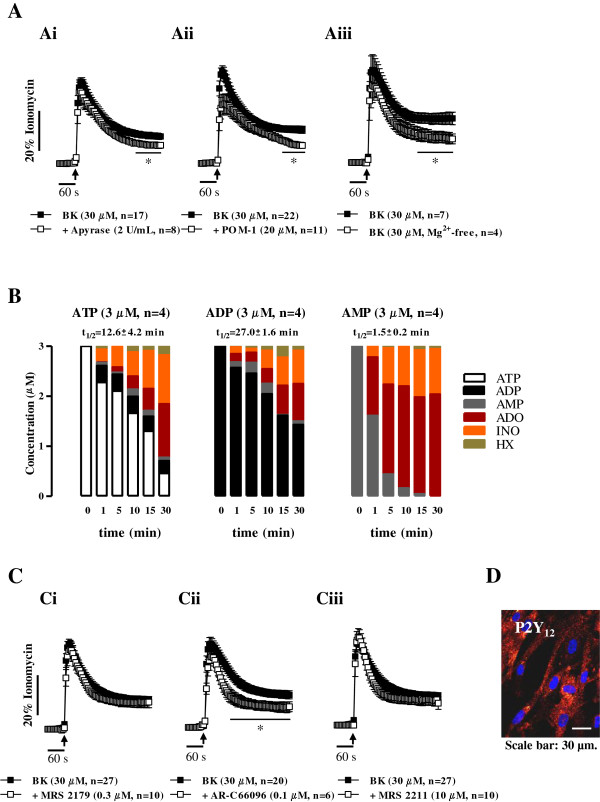
Bradykinin-induced [Ca2+]i mobilization is partially dependent on the activation of P2Y12 purinoceptors. Panel A shows the effect of bradykinin (BK, 30 μM) after pretreating human subcutaneous fibroblasts with apyrase (2 U/mL, Ai), which catabolizes ATP/ADP into AMP, and after inhibition of ectonucleotidases, with POM-1 (20 μM, Aii) or after removing Mg2+ from the incubation fluid (Aiii). Panel C shows the effects of BK (30 μM) in the absence or presence of selective P2Y1, P2Y12 and P2Y13 receptor antagonists, respectively MRS 2179 (0.3 μM, Ci), AR-C 66096 (0.1 μM, Cii) and MRS 2211 (10 μM, Ciii). Cells were pre-incubated with the cell-permeant fluorescent calcium indicator, Fluo-4 NW (2.5 μM, see Methods). [Ca2+]i transients were calibrated to the maximal calcium load produced by ionomycin (5 μM, 100% response). Black arrows indicate the time of drugs application. No changes in baseline fluorescence were observed after application of the modulators. Each point represents pooled data from an n number of experiments. The vertical bars represent S.E.M.. *p < 0.05 represent significant differences from BK (30 μM) alone. Panel B illustrates the time course of the extracellular catabolism of adenine nucleotides in human subcutaneous fibroblasts grown in culture for 11 days. ATP, ADP or AMP (3 μM) were added to the culture medium at time zero; samples (75 μl) were collected at indicated times. Each sample was analyzed by HPLC to separate and quantify ATP (white), ADP (black), AMP (grey), adenosine (ADO, red), inosine (INO, orange) and hypoxanthine (HX, green). Each point represents pooled data from two individuals; 2 replicas were performed for each individual. The calculated half-life time (t½) for each initial substrate is shown for comparison. Panel D shows immunoreactivity of human subcutaneous fibroblasts against the P2Y12 receptor; shown image is representative of three independent experiments. Image scale bar is 30 μm.